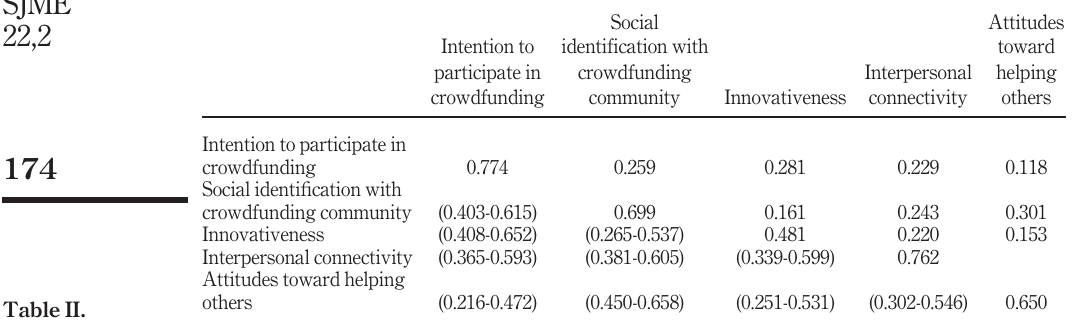
Table II. Measurement of